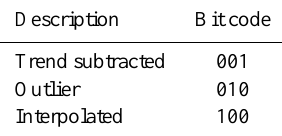
Table 1. Pressure sensors used between 2002 and 2012 at the Time Series Station Spiekeroog (FS: full scale).